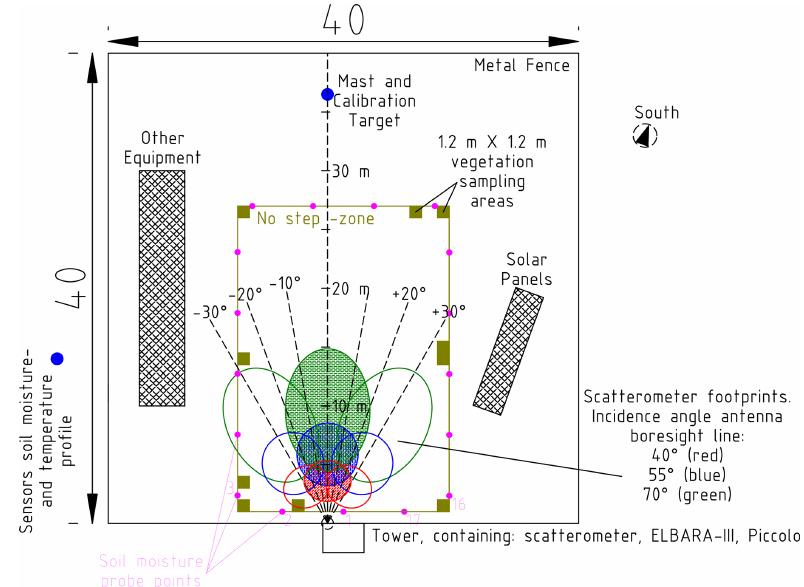
Figure 2. Map of the Maqu site. Scatterometer footprints for C-band with vv polarization are shown for different α 0 (40, 55, 70 ◦ ) and φ ( − 30, − 20, ... , 30 ◦ ) angles. For time-series measurement antennas were fixed at α 0 = 55 ◦ and φ = 0 ◦